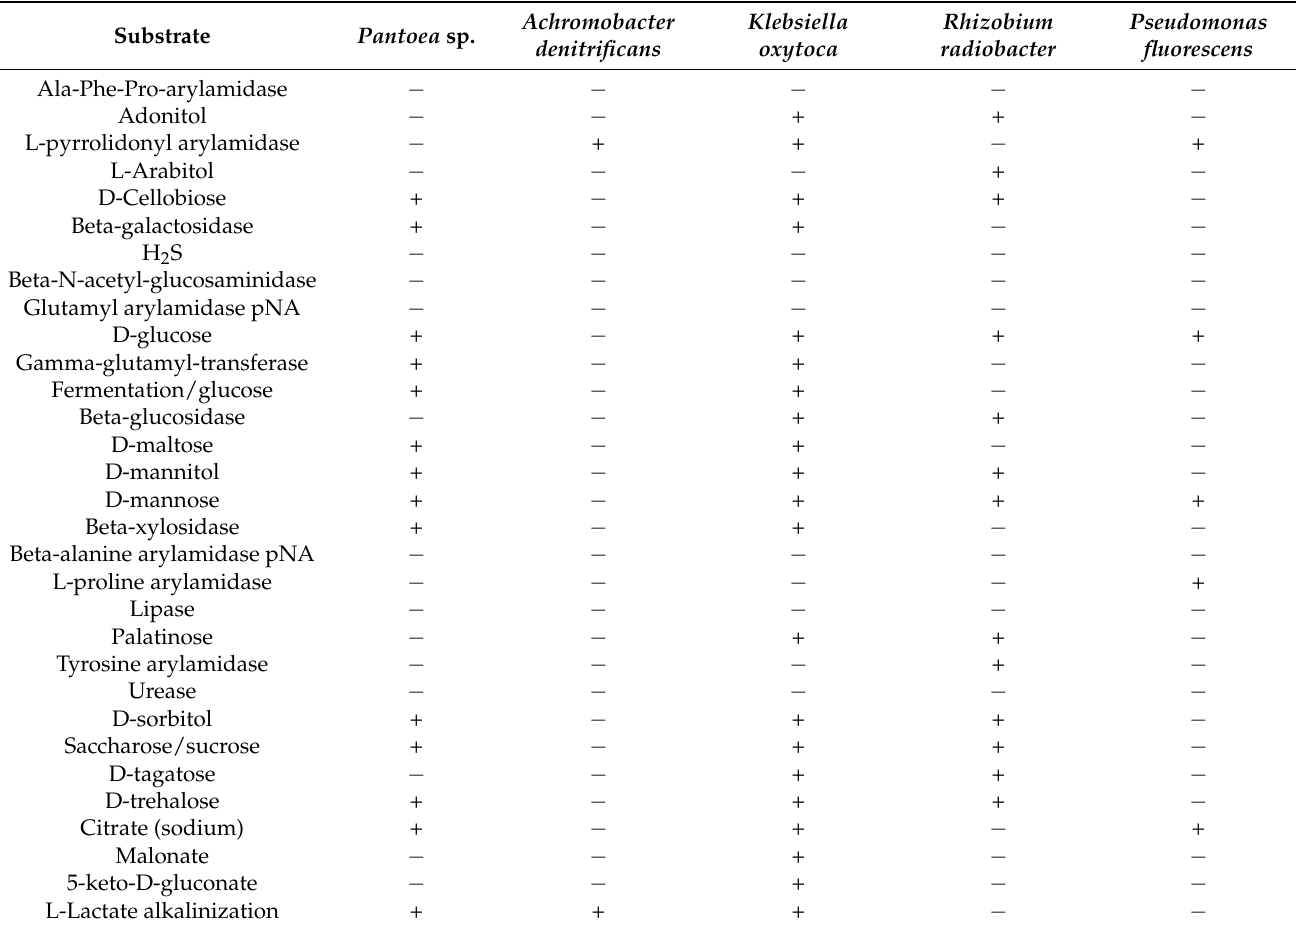
Table 4. Physiological and biochemical signs of